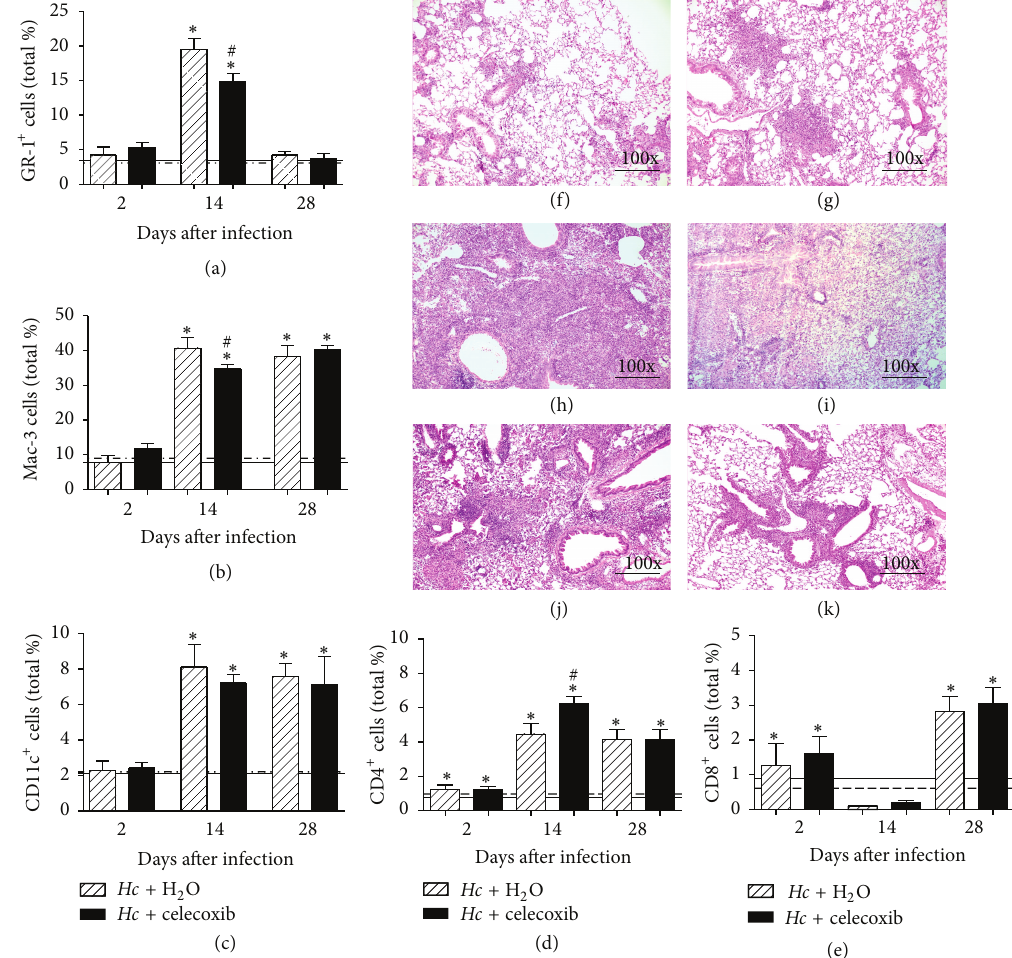
Figure 5: Celecoxib treatment reduces inflammatory cells in the lung parenchyma. At 2, 14, and 28 days after H. capsulatum infection, with or withoutcelecoxibtreatment,thephenotypeofthecellspresentinthelungparenchymawasdetermined.Thecellsweremarkedwithantibodies to GR-1 (a), MAC-3 (b), CD11c (c), CD4 (d), or CD8 (e). Myeloid and lymphoid populations were gated using forward/side scatters. A group of noninfected mice receiving water (solid line) and noninfected mice treated with celecoxib (dotted line) were used as controls. The lung tissues were also processed and stained with H &E to identify leukocyte infiltration after 2 (f, g), 14 (h, i), and 28 days (j, k). The lung sections from H. capsulatum -infected mice receiving water p.o. (f, h and j) or celecoxib (g, i and k). Magnification: 100x. The data are presented as the means ± SEM representative of three independent experiments (𝑛 = 5 - 6) . One-way ANOVA (Tukey’s multiple comparison test) was used. ∗ PBS + H # Hc + H 𝑃 < 0.05 2 O versus Hc + H 2 O or versus Hc + celecoxib; 2 O versus Hc + celecoxib